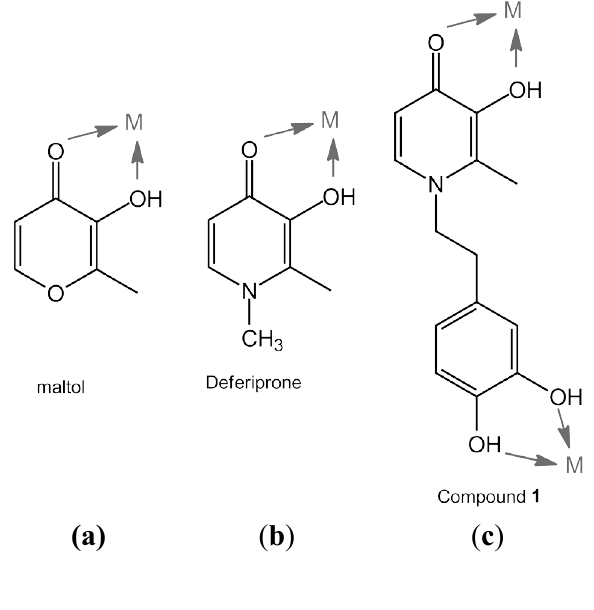
Figure 1. The structures of ( a ) maltol; ( b ) Deferiprone; and ( c ) the pyridinone derived from dopamine ( 1 ) showing the possible binding sites to